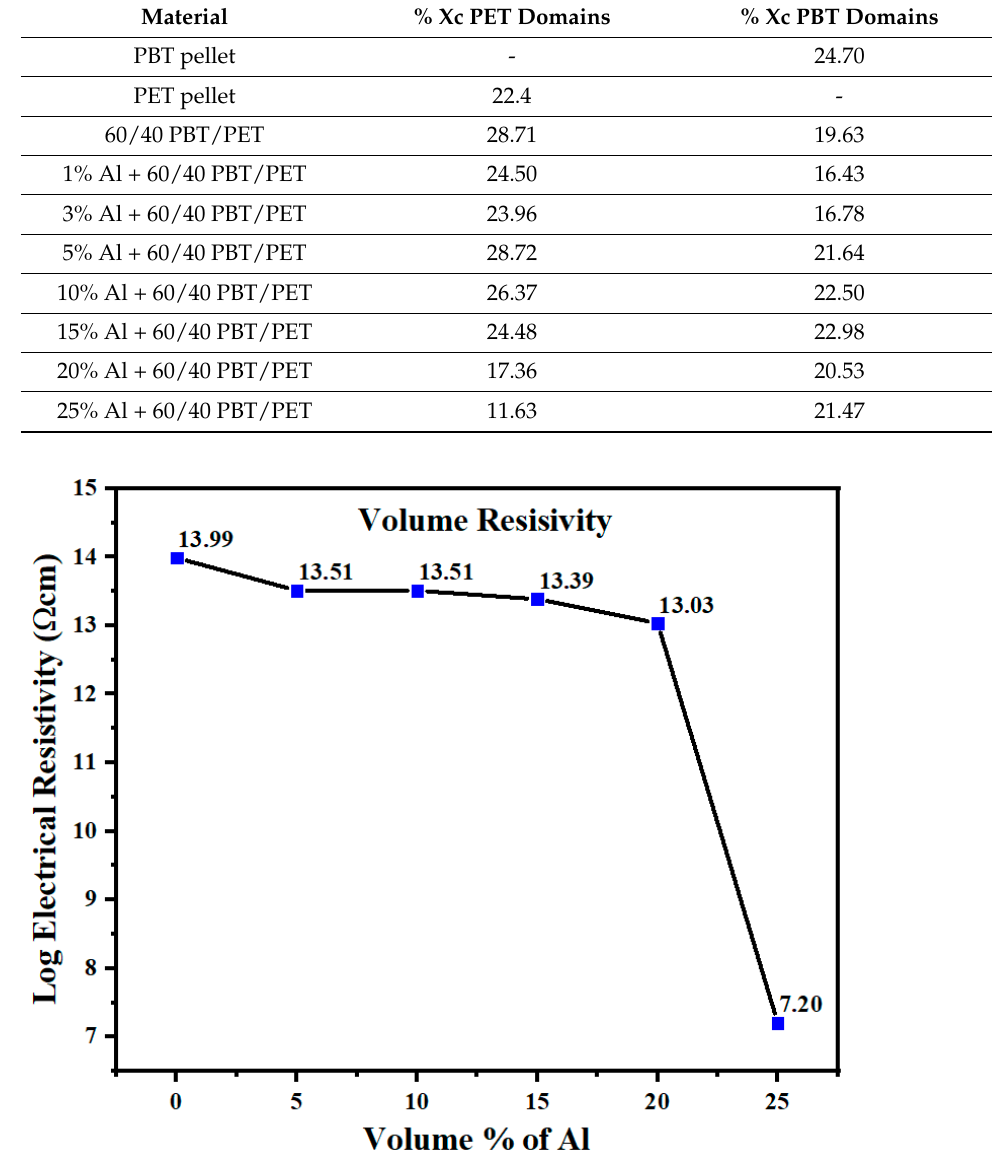
Figure 7 . Electrical resistivity of 60/40 PBT/PET blend and Al nano platelet-filled 60/40 PBT/PET. The percolation threshold with Al nano platelets is 20–25 vol.%.